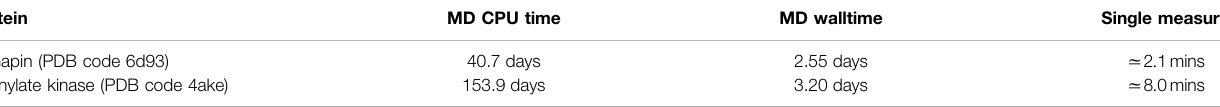
TABLE 1 | Computational cost of all-atom MD simulations and mapping entropy calculations for the two investigated proteins. Speci fi cally, MD CPU time (respectively, MD walltime )represents thecoretime(respectively,usertime)necessarytosimulatethesystemfor200 nsontheGROMACS2018package(Spoeletal.,2005).Both 6d93 and 4ake runs were performed on Intel Xeon-Gold 5118 processors, respectively, using 16 and 48 cores. Single measure is the amount of time that is required to compute, on a single core of the same architecture, the S map of a given CG mapping by relying on the algorithm introduced in Giulini et al. (2020). Protein